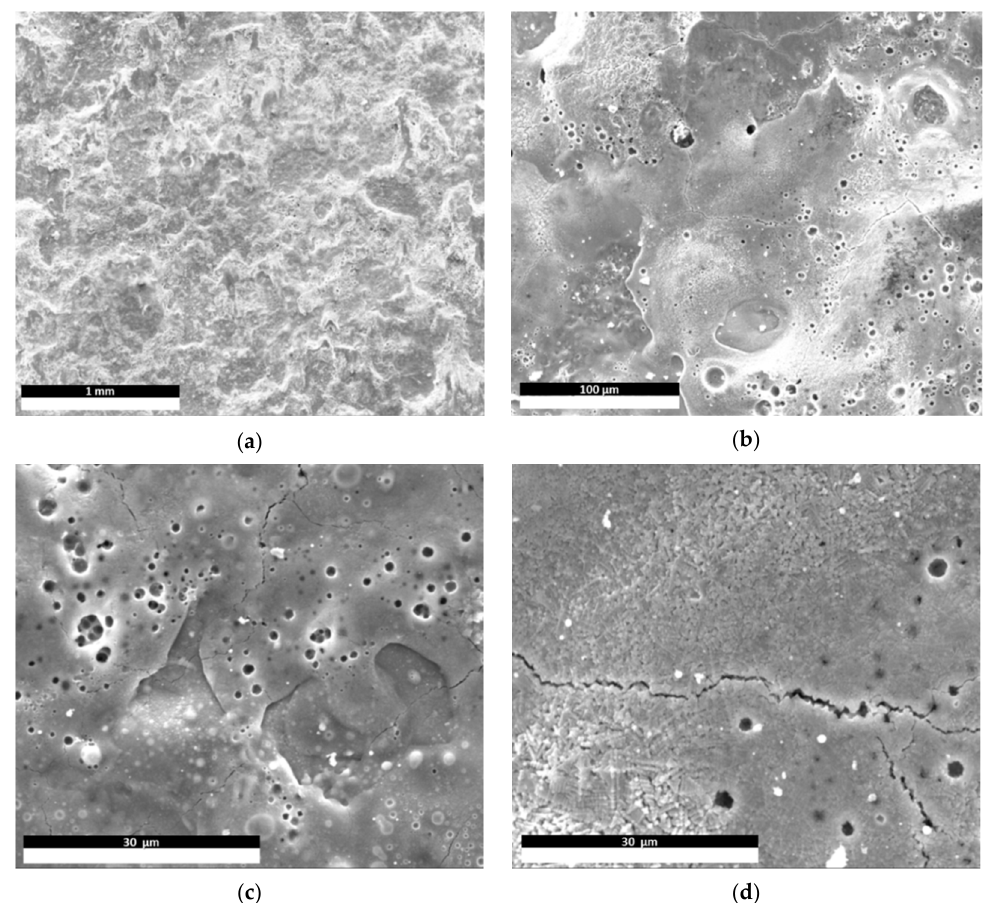
Figure 2. SEM and topography surface analyses results for the CoCrFeNiMo 0.85 HEA coating deposited by electrospark deposition technique; ( a ) electron microscopy result, ( b ) topography indicating homogenous plateaus, ( c ) topography—presentation of pores, ( d ) topography—dendritic structures are present.